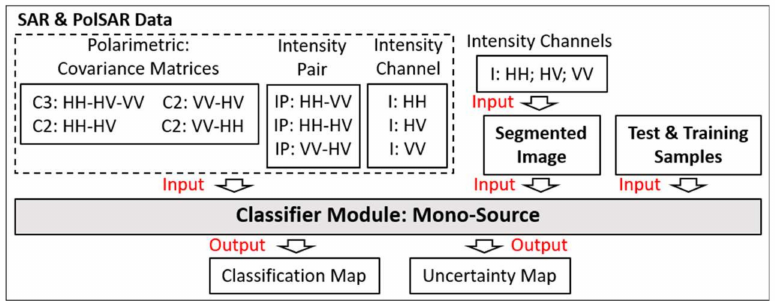
Figure 3. The statistical region-based classification methodology, indicating the input and output